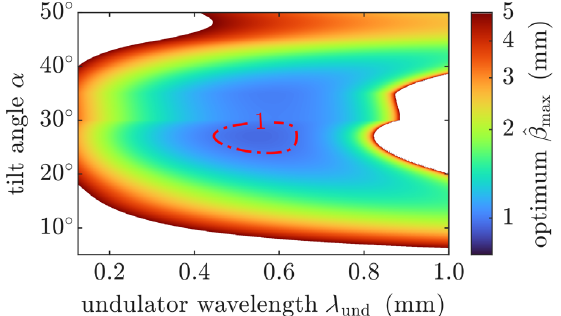
ˆ β for α ¼ 27 °, the max